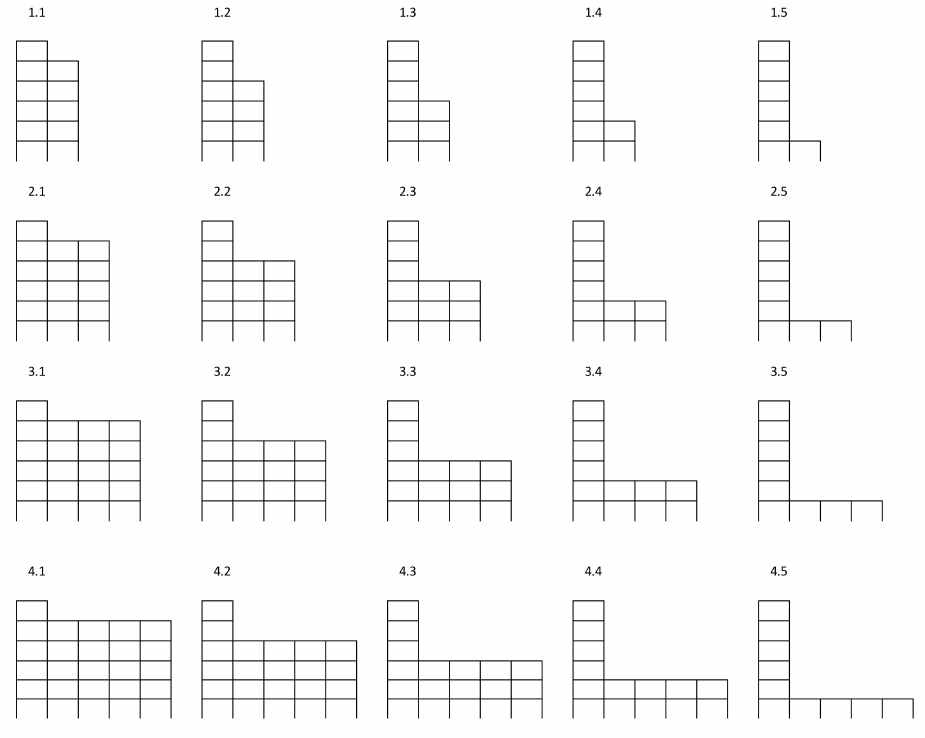
Figure 13. Generic 2D frame structures of stepped setback model.